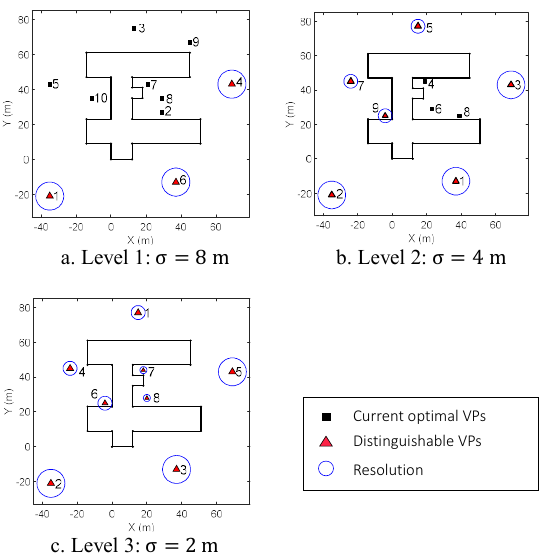
Figure 8. Solutions from the “Hierarchical + WGA” strategy for CCIT: three levels of resolutions are applied before the stop criterion was